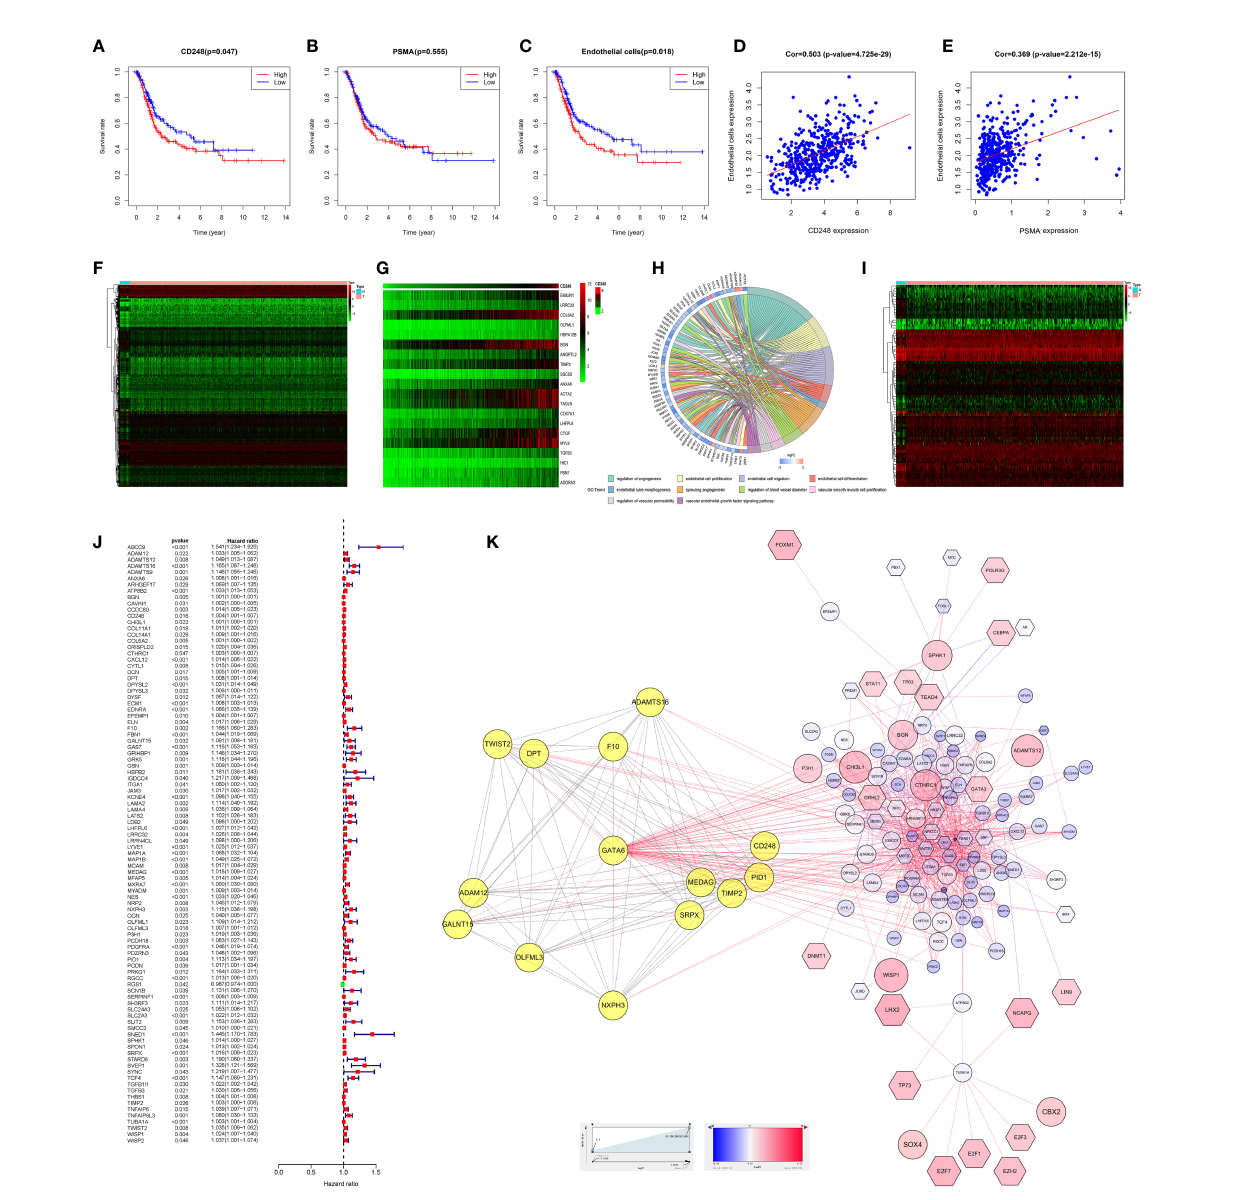
FIGURE 5 | Bioinformatic analysis of CD248 and PSMA using TCGA-BLCA dataset. Kaplan-Meier curve of CD248 (A) , PSMA (B) , and the endothelial cell score (C) . Correlation between the endothelial cell score and CD248 expression (D) . Correlation between the endothelial cell score and PSMA expression (E) . Heat map of DEGs (F) . Co-expressed heatmap of top 20 Cor-DEGs (G) . Green to red spectrum indicates low to high gene expression. GO enrichment analysis of Cor-DEGs (H) . Heat map of DETFs (I) . Forest graph of PCor-DEGs (J) . The red and green dots represent PCor-DEGs with a hazard ratio >1 and ≤ 1, respectively. TFs-based regulatory network for PCor-DEGs (K) . P < 0.05 or FDR < 0.05 was considered statistically signi fi